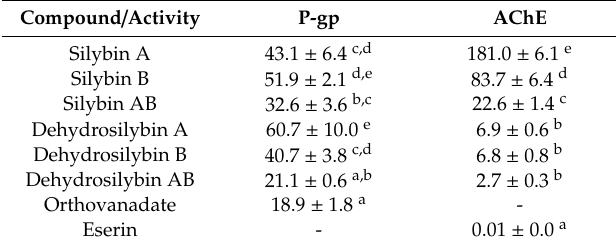
Figure 7. Modulation of P-glycoprotein (P-gp) ATPase activity by silybin diastereomers ( a ) and dehydrosilybin enantiomers ( b ). The assay was realized using the commercial P-gp-Glo assay system (Promega, Madison, WI, USA) including a membrane fraction with recombinant human P-gp. Data represent the average of three repetitions with corresponding standard error of the mean. Table 6. The e ff ect of silybin and dehydrosilybin stereomers on the acetylcholinesterase activity and e ffl ux pump